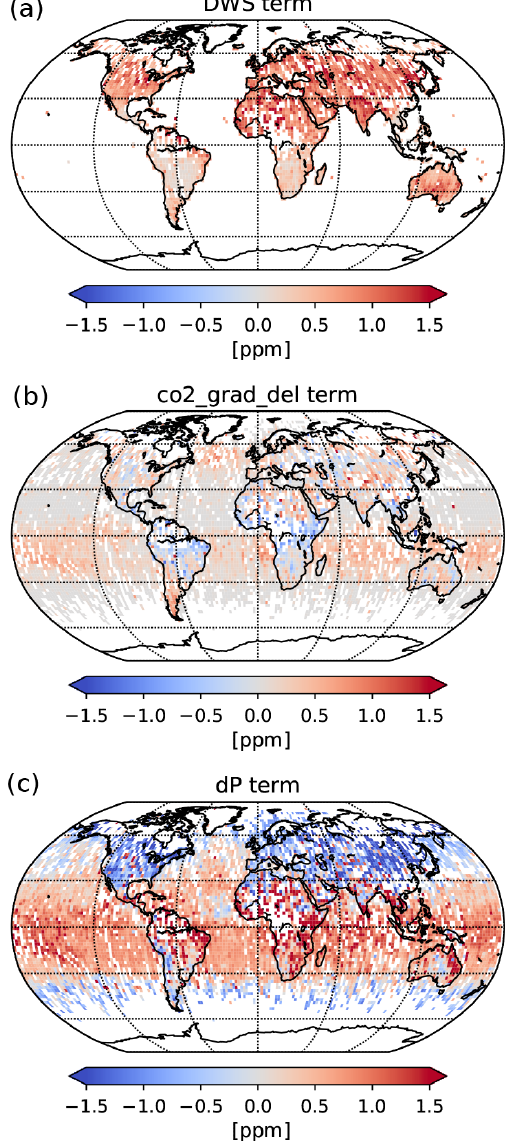
Figure 10. Contributions of the parametric bias correction terms to raw X CO from DWS ( a , only over land), co2_grad_del (b) , and 2 the two d P terms over land and ocean (c) for April 2016. Data are aggregated into 2 ◦ × 2 ◦ latitude–longitude square grids.